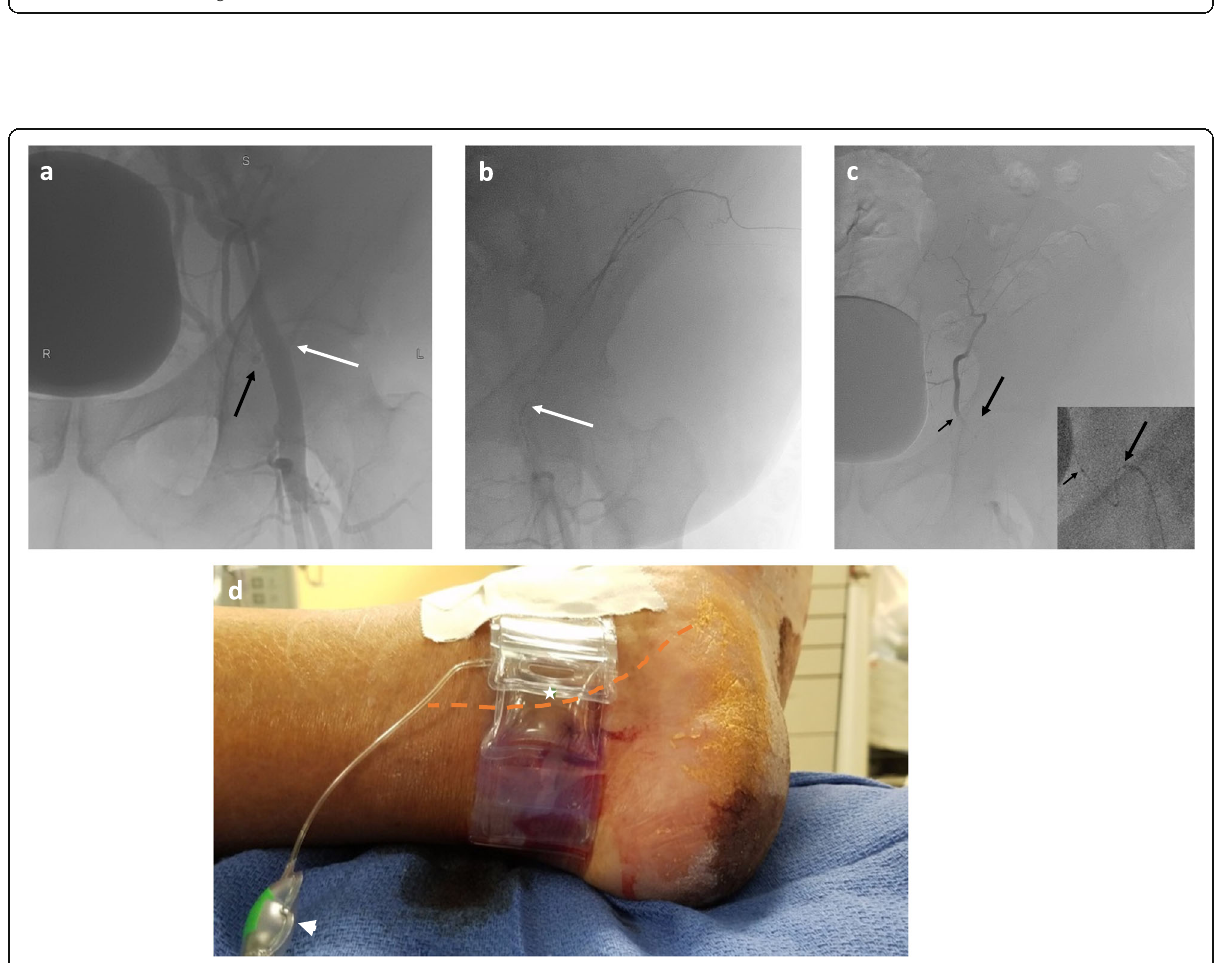
Fig. 3 Patient 2 Seat-belt injury and ipsilateral tibial access: Axial contrast enhanced CT following seat-belt injury demonstrating contrast extravasation (arrow) in the left anterior abdominal hematoma (*) ( a ). Ultrasound guided access into the distal PTA (*) ( b ). Hand injection through vascular sheath following PTA access ( c )